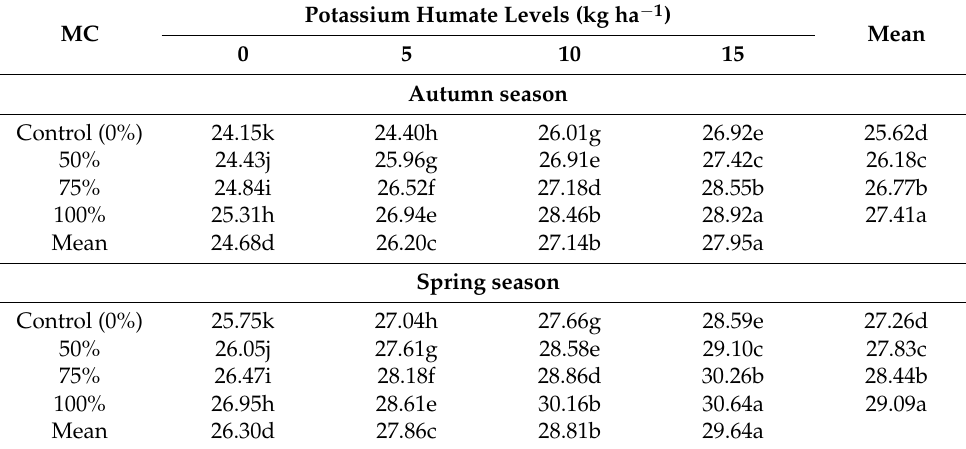
Table 2. Total fruit yield (tons) per hectare of tomato affected by various K-humate and MC levels under the field conditions during